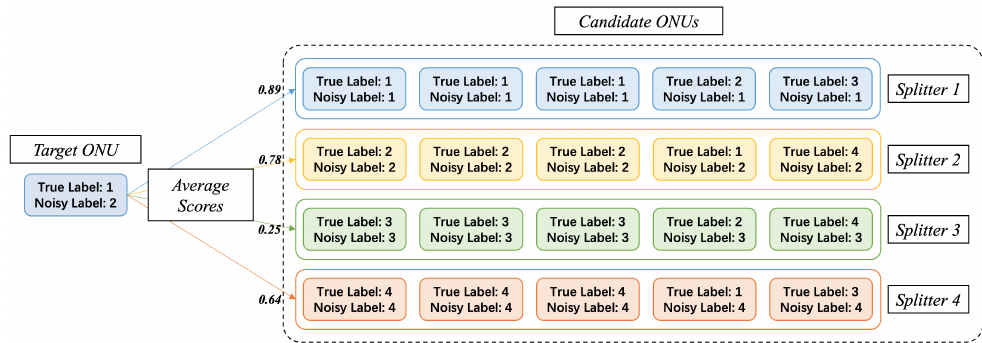
Figure 7. Average voting from ONUs to secondary splitters. Noisy label is provided by RMS. True label is temporarily unknown to us, but it exists objectively and is to be found.